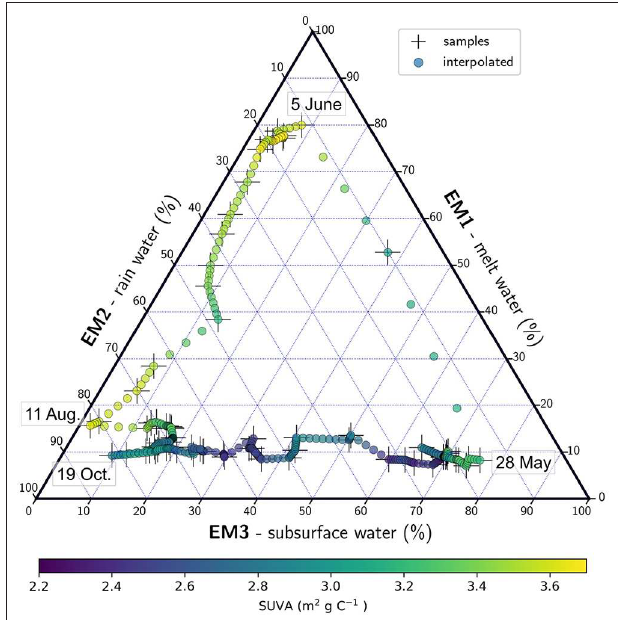
FIGURE 8 | Water source fractions for each sample (cross) and each interpolated day (colored circle) based on EC and stable isotope endmember calculations; Color shows the SUVA. The extreme values of the water source fractions are indicated by